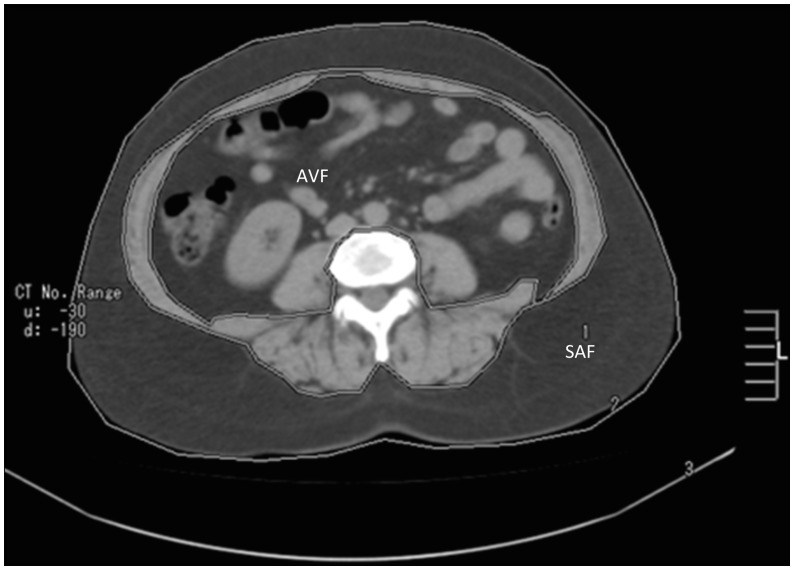
Cross sectional (axial) area of subcutaneous abdominal fat (SAF) and abdominal visceral fat (AVF) on L4–L5 vertebrae topography.Each area comprehends contiguous images within outlined boundaries.